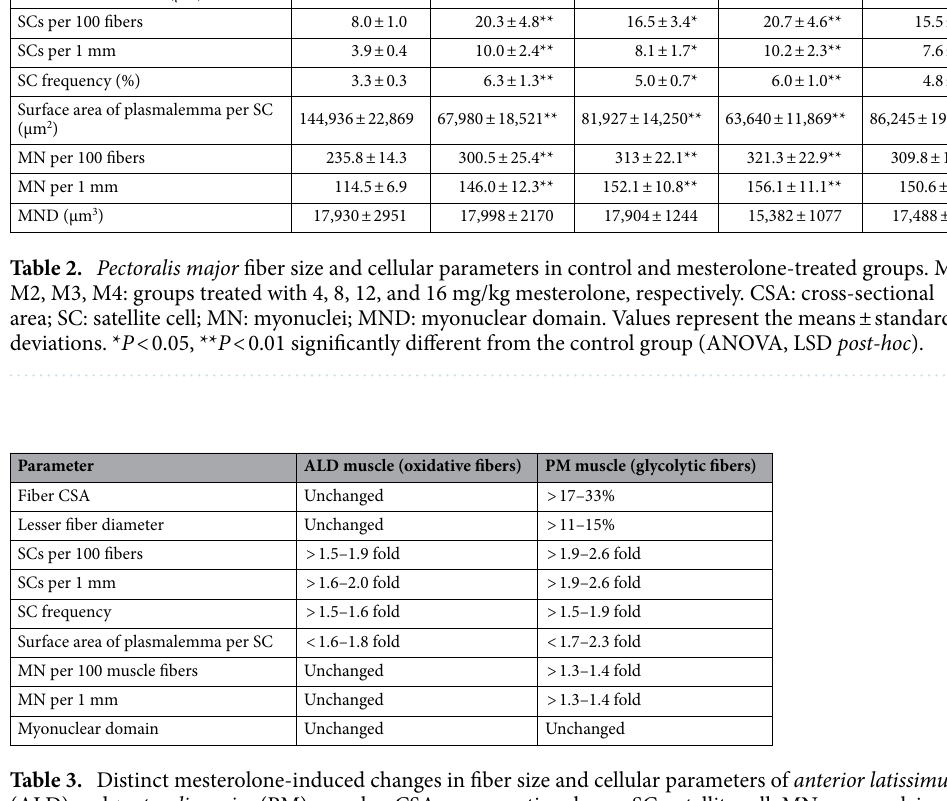
Parameter Control